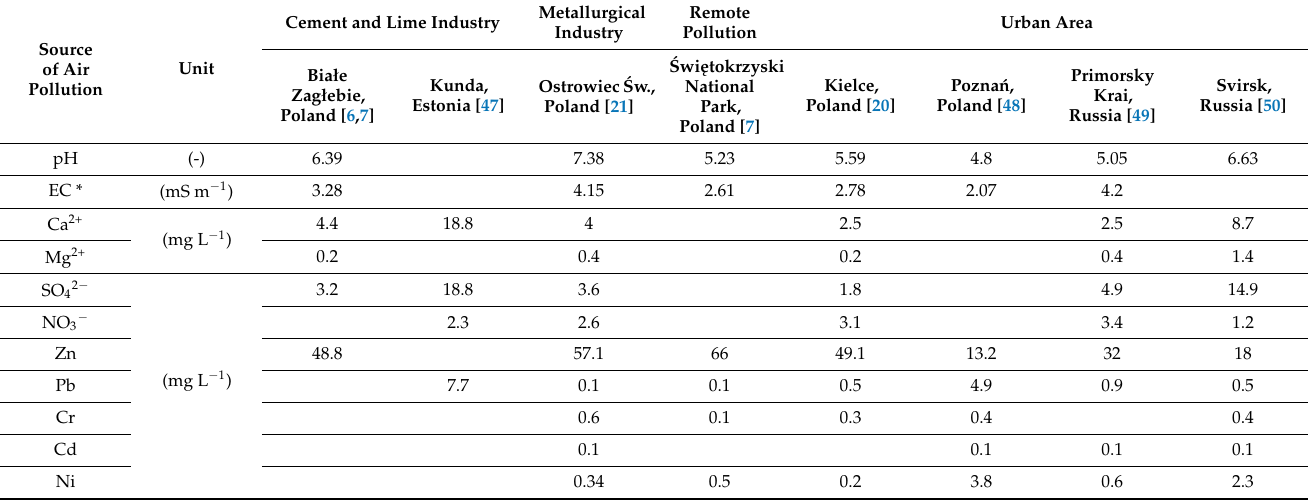
Table 4. Comparison of the chemical analysis of the snow cover in Poland and other